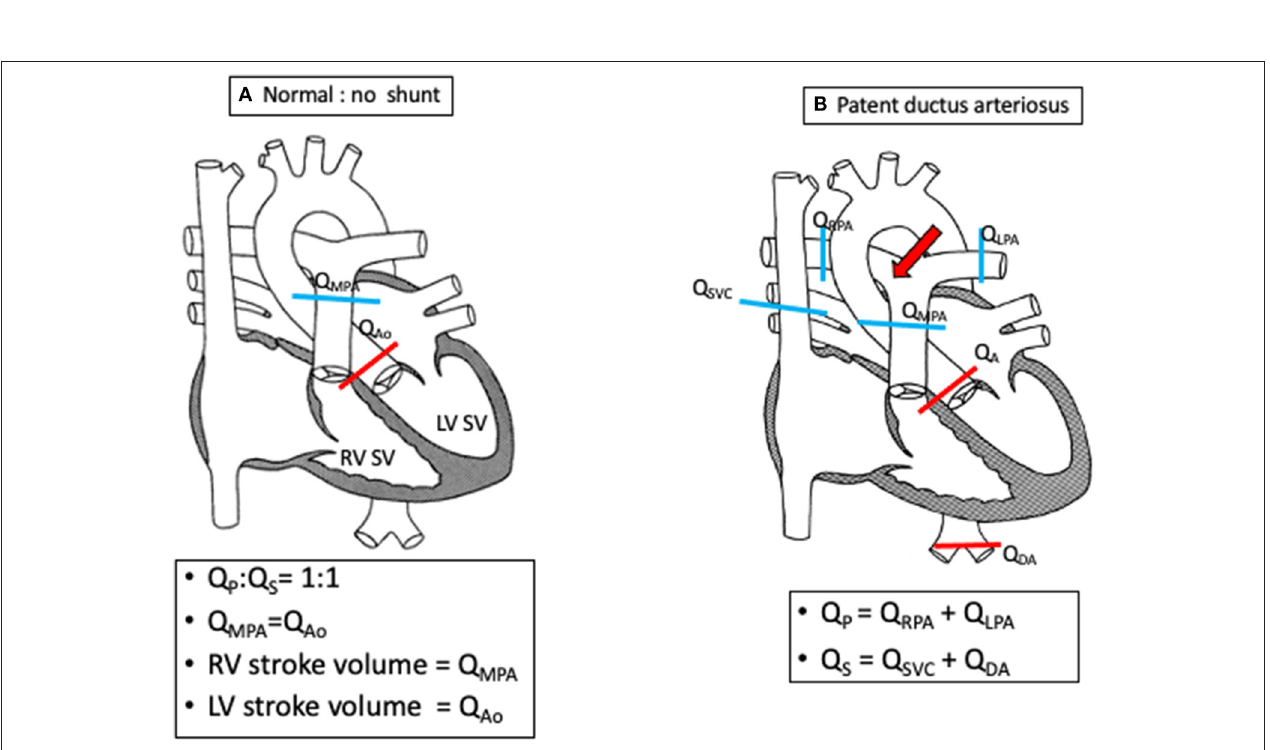
FIGURE 4 | Schematics demonstrating shunt calculations (Qp:Qs) in a normal heart (A) and in a PDA (B) using flow quantification from cardiac magnetic resonance imaging.